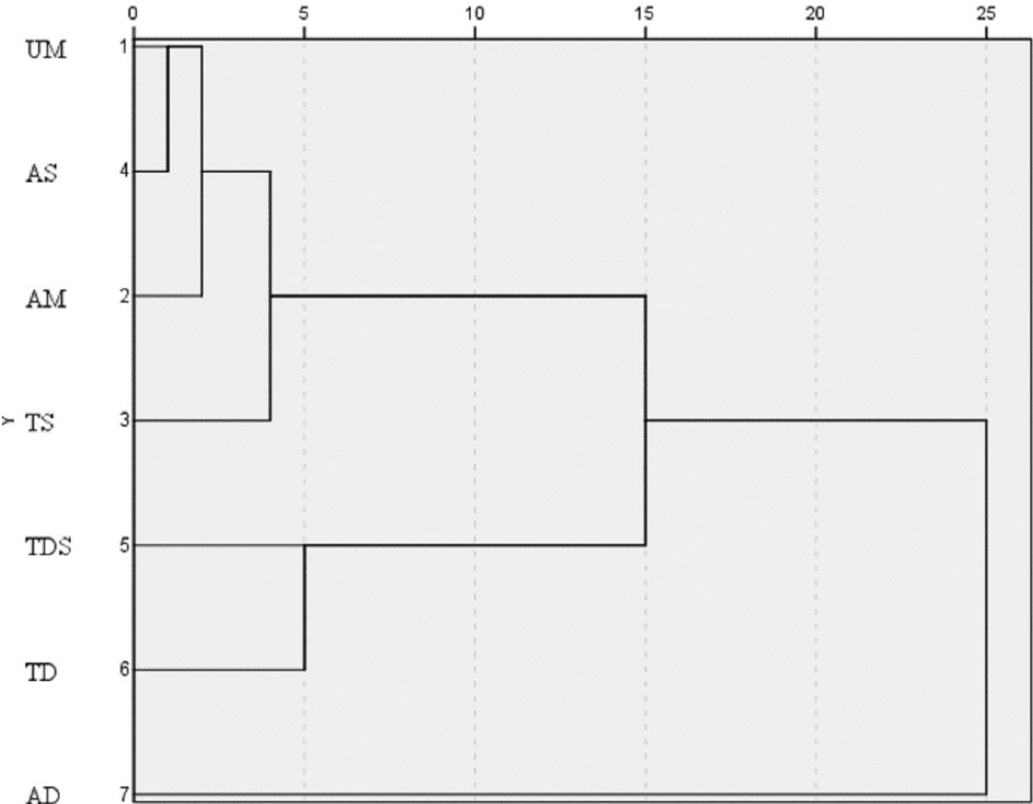
Fig 5. Clustering analysis of different types